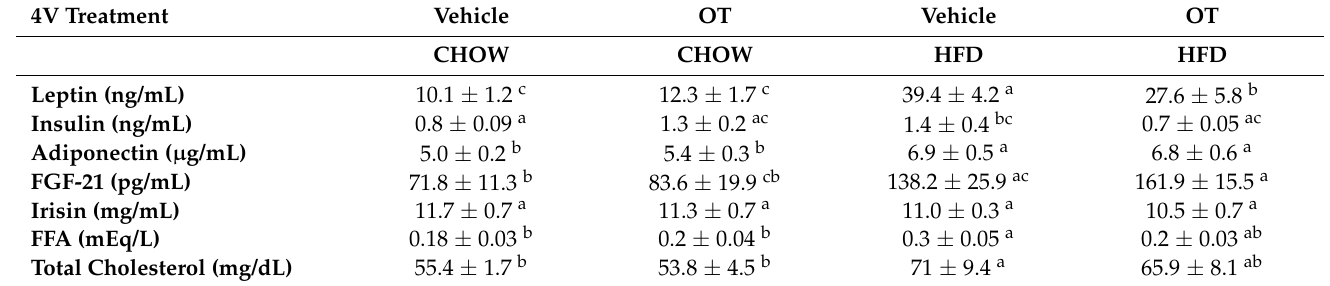
Table 2B. Plasma Measurements at